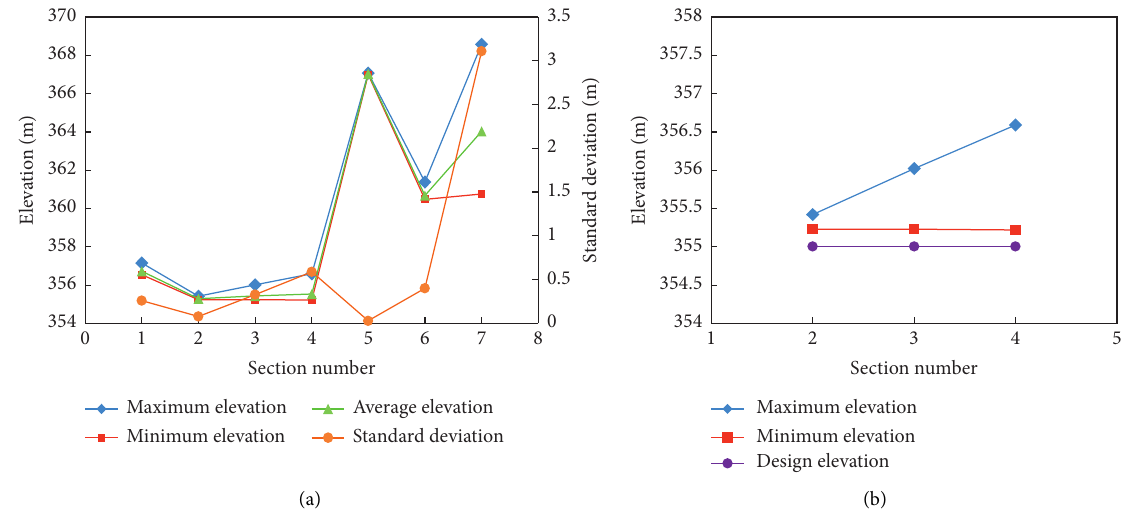
Note . The data in the table is based on the statistical calculation of multiple corresponding measurement points on each section.